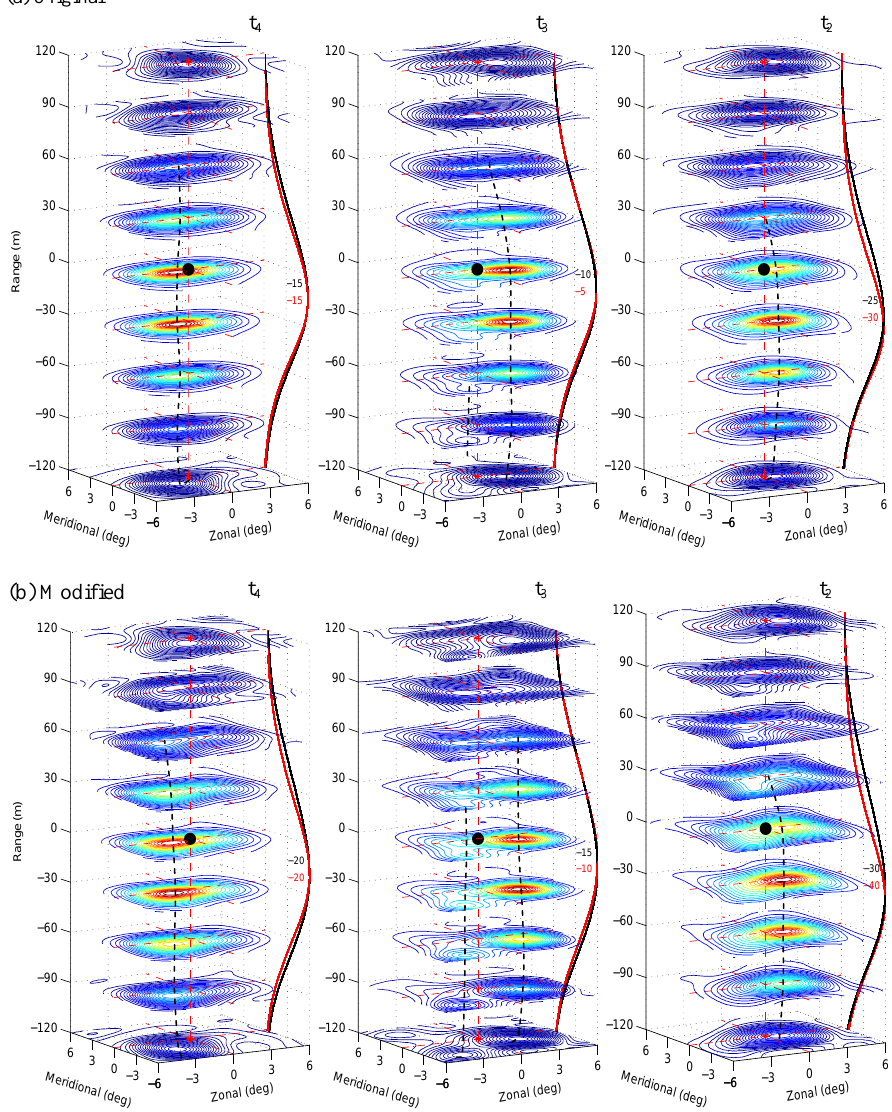
Figure 3. 3-D radar imaging at the time slots 4, 3, and 2 (from left to right) indicated in Fig. 2d. The 2-D contoured brightness distributions of nine slices at range locations of − 120, − 90, − 60, − 30, 0, 30, 60, 90, and 120m are displayed. The 0m location corresponds to the range of 5.325km. The unit of the brightness value is dB, but normalization is made for individual time slot. (a) and (b) are the imaging results, respectively, with and without correction of spatial weighting effect. The thick dashed curve in black links the major echo centers at several range locations. Black spot is the central location of the radar volume. Two types of 1-D RIM profiles are shown on the range-meridional plane: (black) summation of the brightness values at equal-range surface, (red) the brightness values along the zenith direction.